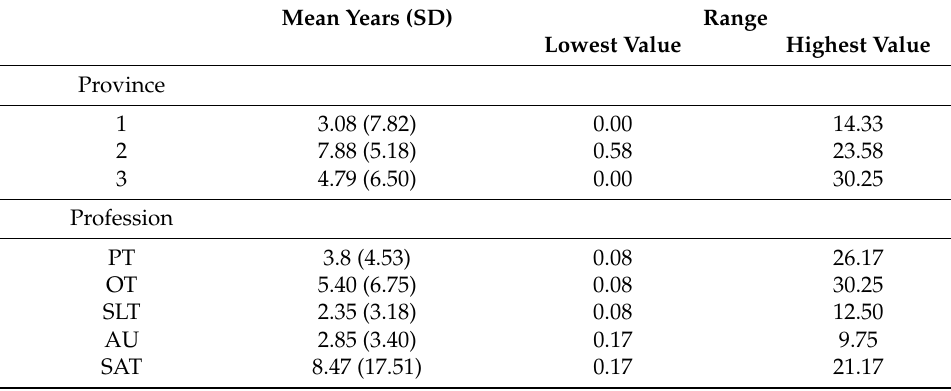
Table 3. Years that therapists worked at their current facilities according to province and profession, as derived from the web-based therapist